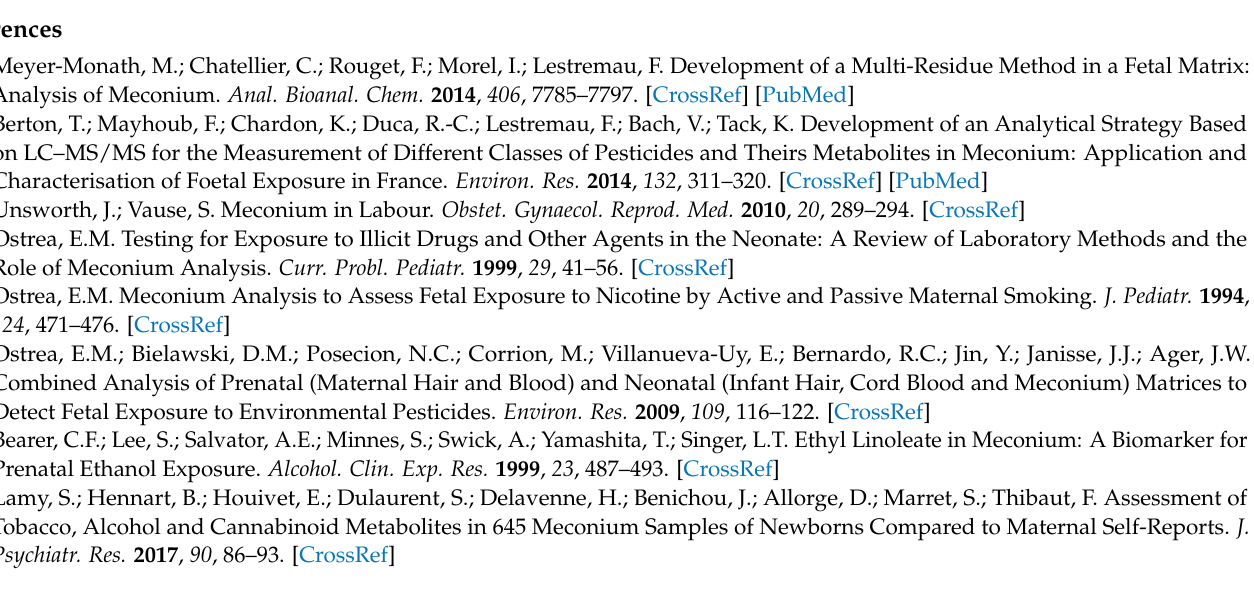
Table S4: Summary of statistical modeling of the time-dependence variation of the metabolome distribution in C18-ESI + and HILIC-ESI − datasets. Table S5: List of external standards used for meconium